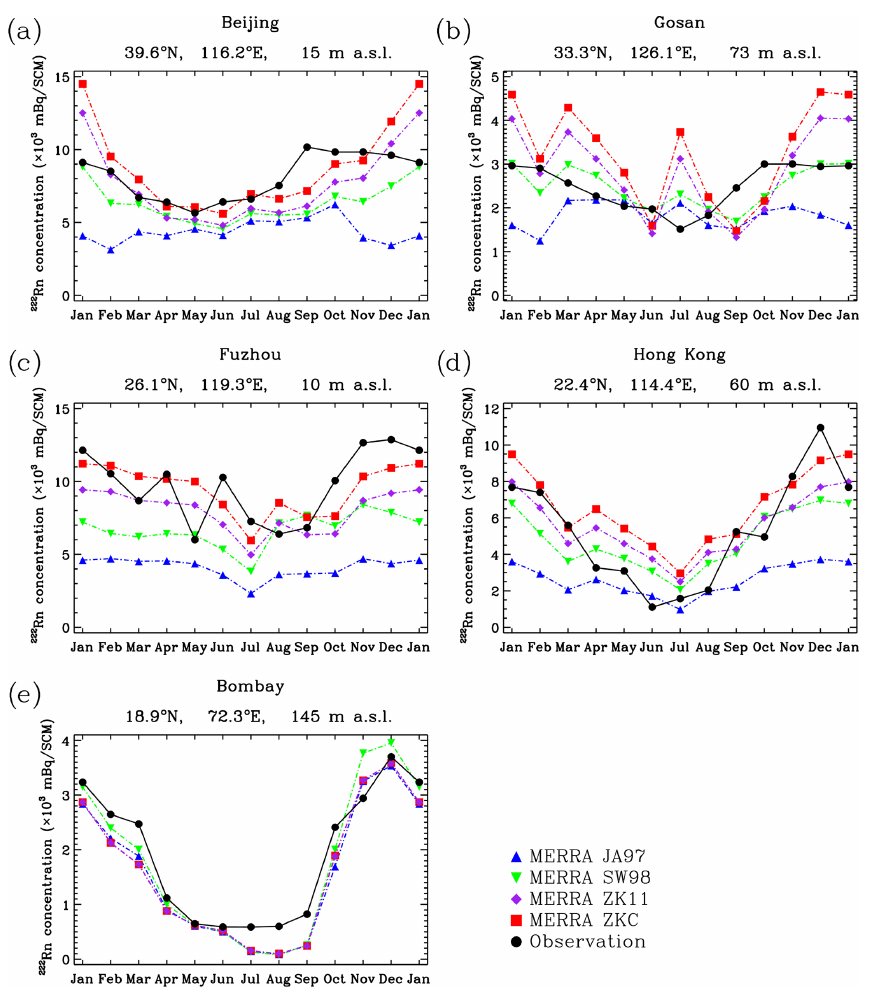
Figure 9. Same as Fig. 8 but for Asia. Note that the model results used in (c) Fuzhou and (d) Hong Kong are sampled at the grid boxes to the west of the ones where the sites are located to achieve a better agreement with the observations. See text for